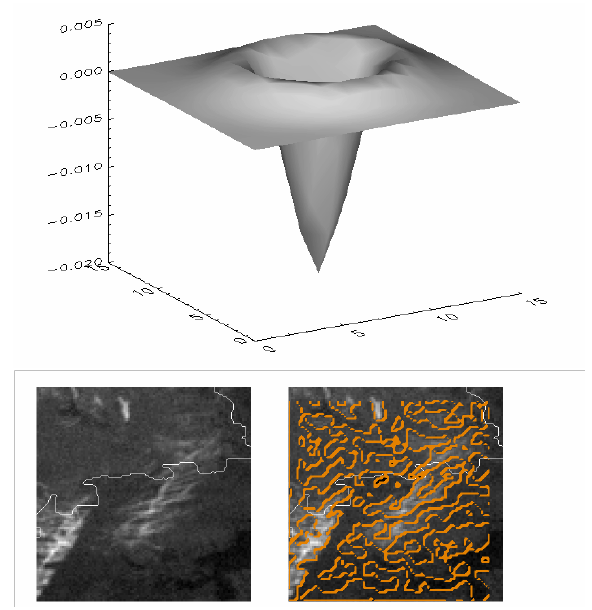
Fig. 012. Top: Laplacian of Gaussian filter applied, on a 16 × 16 grid, with σ = 2 . Bottom: Left: BTD image corresponding to 17 June 2009 07:00UTC covering part of the North Sea, northern Fig. 12. Top: Laplacian of Gaussian filter applied, on a 16 × 16 grid, Germany and western Denmark. Right: in orange, edges identified with σ = 2. Bottom: Left: BTD image corresponding to 17 June when applying LoG filter to the BTD image. 2009 07:00UTC covering part of the North Sea, northern Germany and western Denmark. Right: in orange, edges identified when ap- plying LoG filter to the BTD